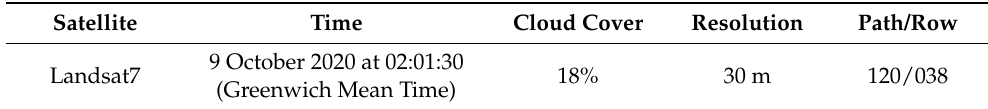
Table 1. The type of landscape